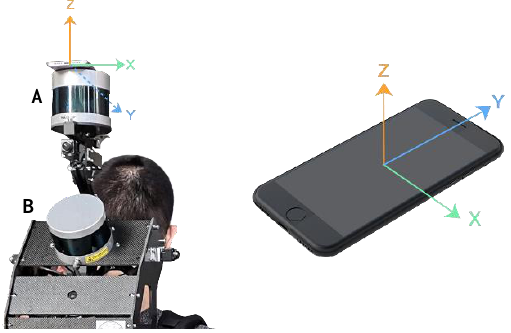
Figure 9. The smart phone’s position and coordinate.